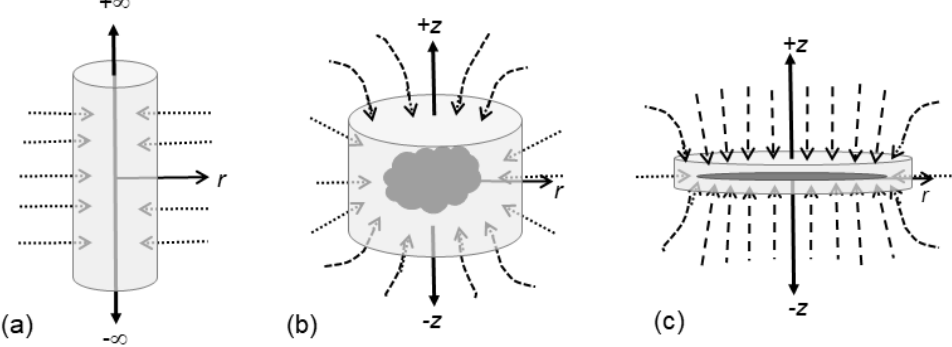
Figure 11. Lines of force in cylindrical geometry, showing how these depend on the aspect ratio of the central body (dark gray). The light gray cylinders are imaginary shapes constructed to evaluate the divergence of the lines of force, per Gauss’ method: ( a ) Line source, where force lines need only be computed in the radial direction; ( b ) Stubby body, showing edge effects and bending force lines, which are only perfectly straight along the z and r axes; ( c ) Thin disk. Away from the edges, flux is essentially vertical, and analytic (Equation (11)), with no discontinuities.